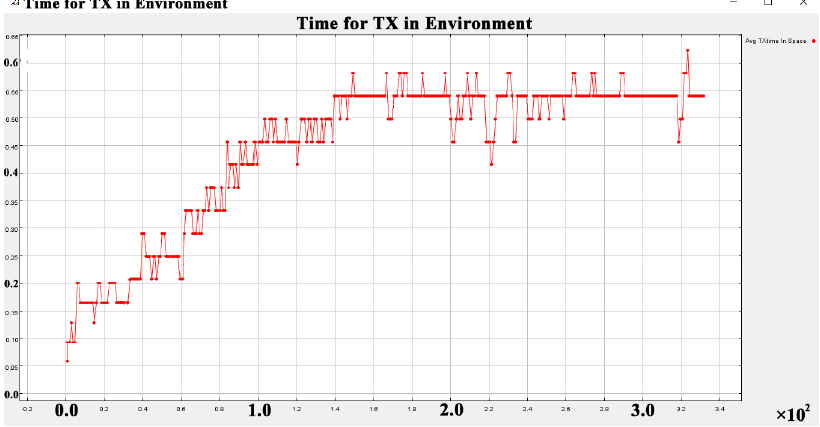
Figure 11. Time cost curve – private